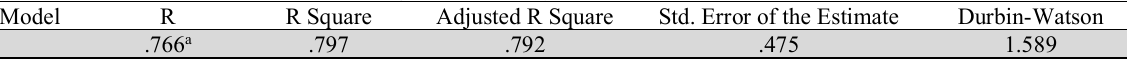
The results of the statistical test for regression analysis